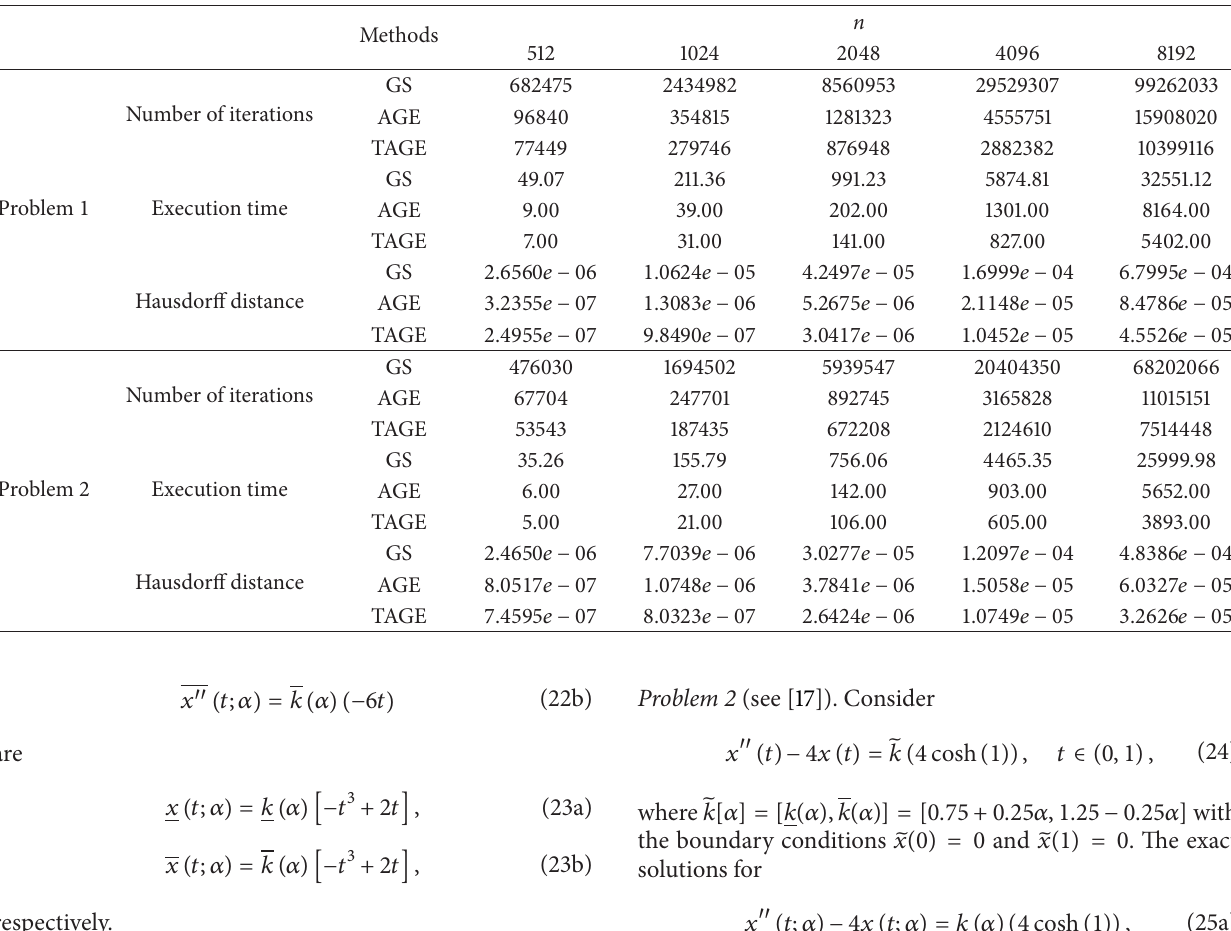
Table 2: Comparison of three parameters between GS, AGE, and TAGE methods at 𝛼 = 0 .